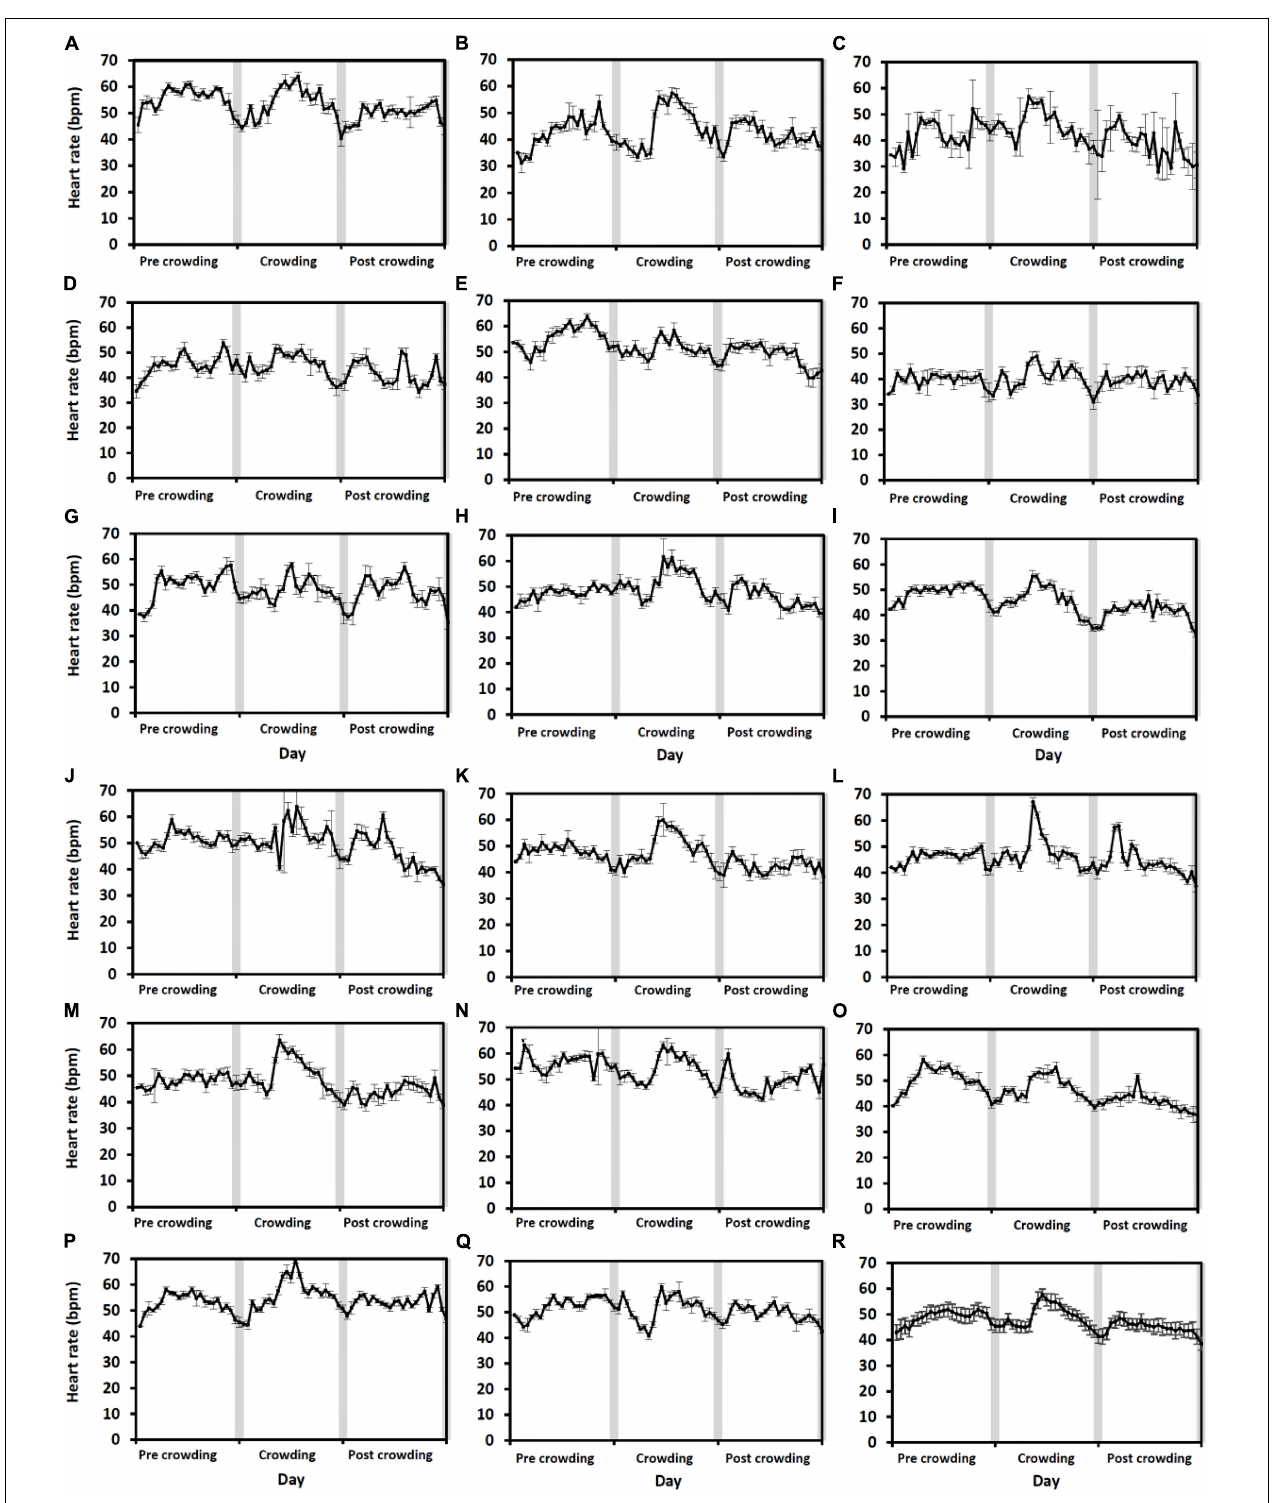
FIGURE 4 | Level 2 crowding event fish response. Average hourly heart rate (black line) in bpm of 17 individual salmon [Graphs (A–Q) ] undergoing a level 2 crowding event. Hourly heart rates are shown from the day prior to crowding (the 15th of June), on the day of crowding (the 16th of June), and the day post-crowding (the 17th of June). Error bars for individual fish graphs represent hourly mean heart rate ± 95% CI. Graph (R) represents the average hourly heart rate of all 17 fish (Error bars show ± 95% CI). Gray bars indicate approximate civil hours of darkness.